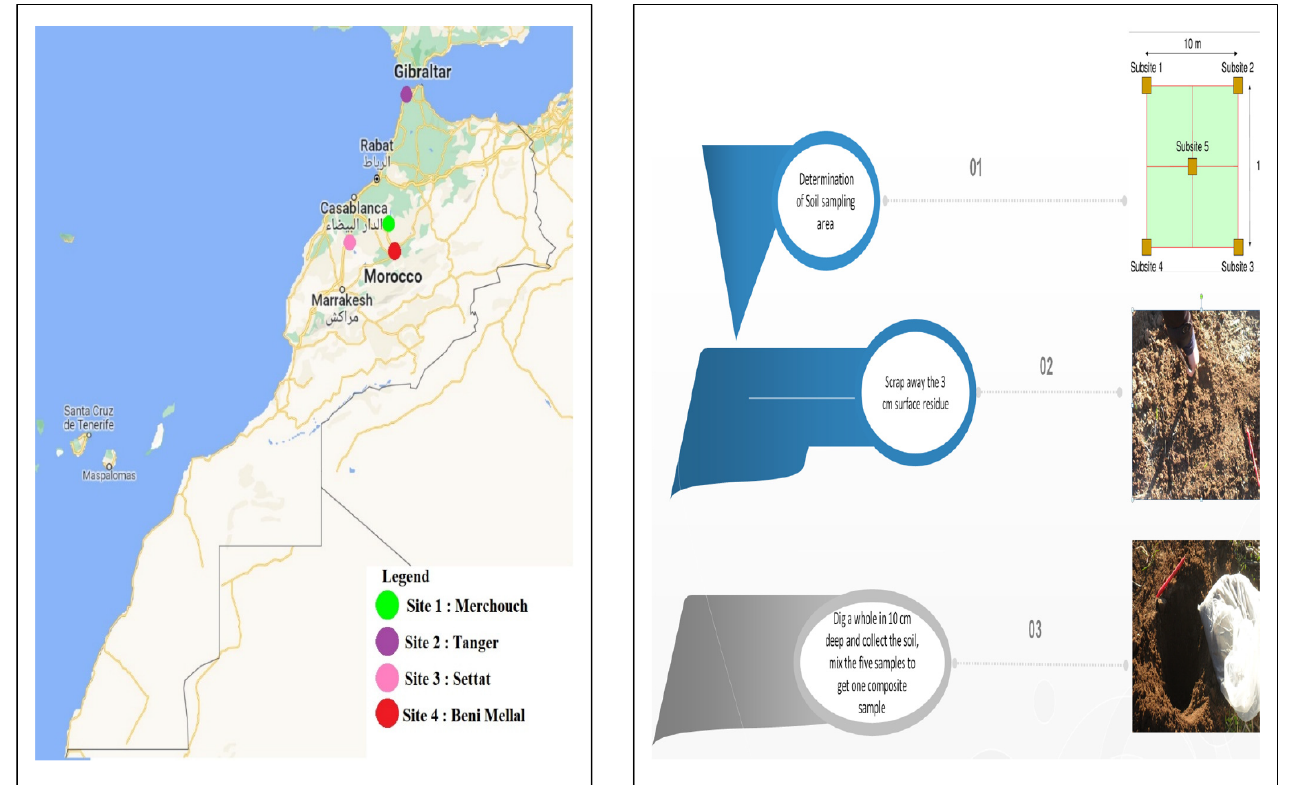
Figure 1. Sampling sites and schematic of the oat agricultural soils studied in Morocco.